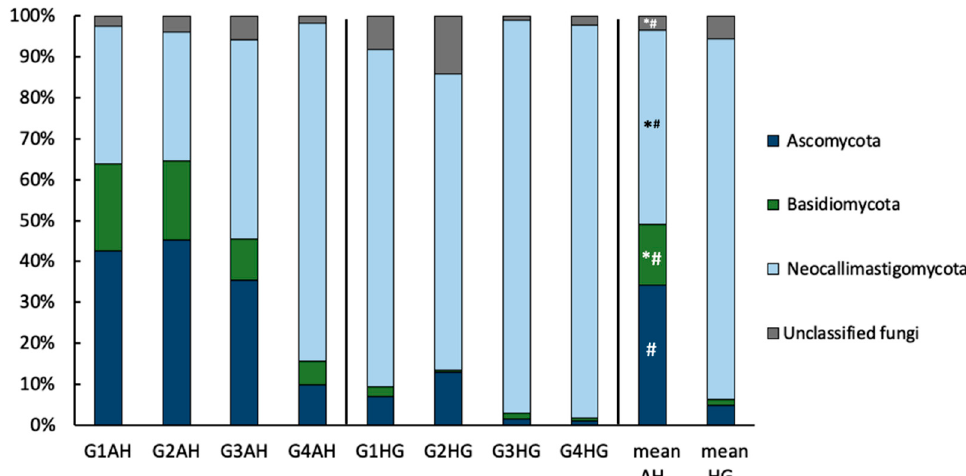
Figure 3. Relative ruminal, fungal community composition at phylum-level of goats fed an AH diet (left) or HG diet (middle) and mean values of both treatments (right), respectively. Results are based on amplicon sequencing of the ITS2 region and phyla ≥ 1% abundance are depicted. Significant changes between treatments are indicated by an asterisk ( t -test on relative genus-abundance data) or hash (based on DESeq2 analysis of ASV raw data).